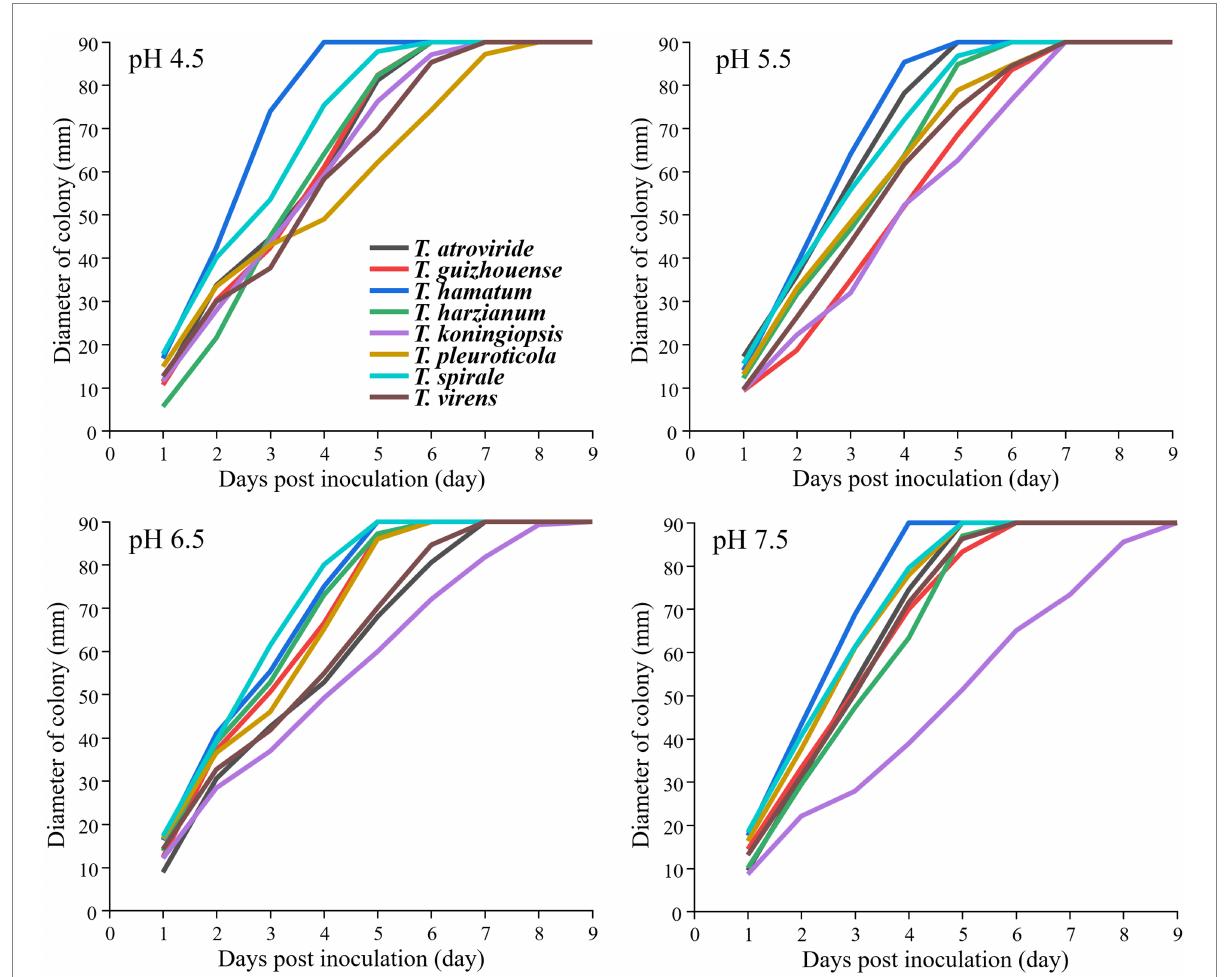
FIGURE 5 Effects of different pH levels on the mycelial growth of different Trichoderma strains on the PDA plates at 26 ° C. Data represent the mean of two independent replicates with three plates